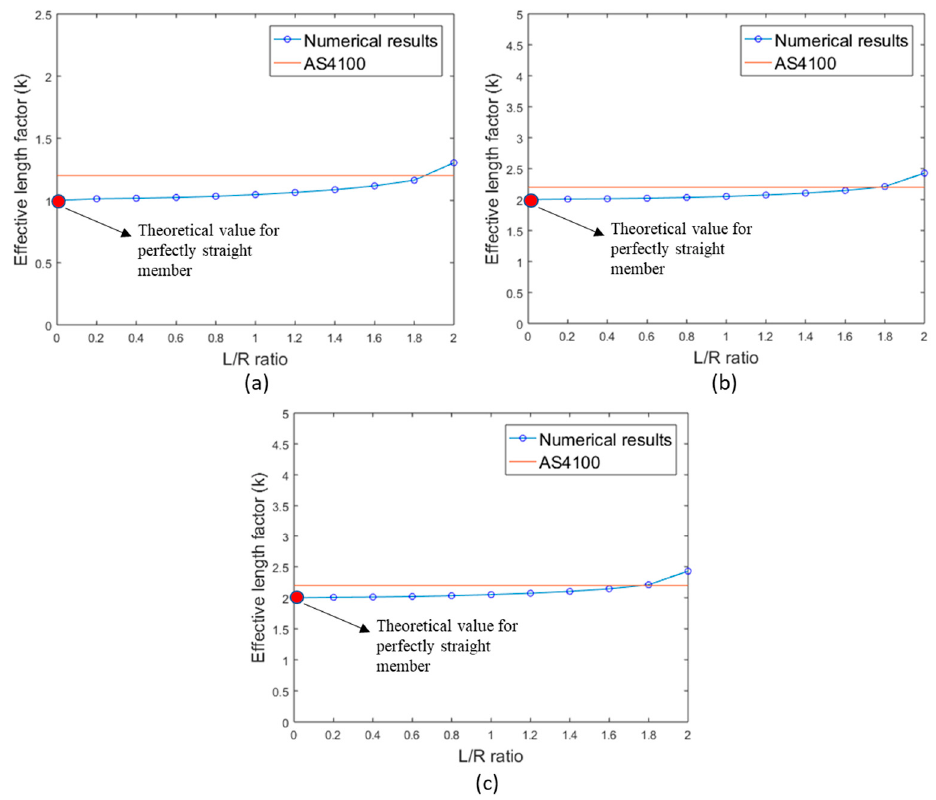
Figure 20. The effective length factor ( k e ) of curved beams under different L/R ratios: ( a ) sway member case 1; ( b ) sway member case 2; ( c ) sway member case 3.